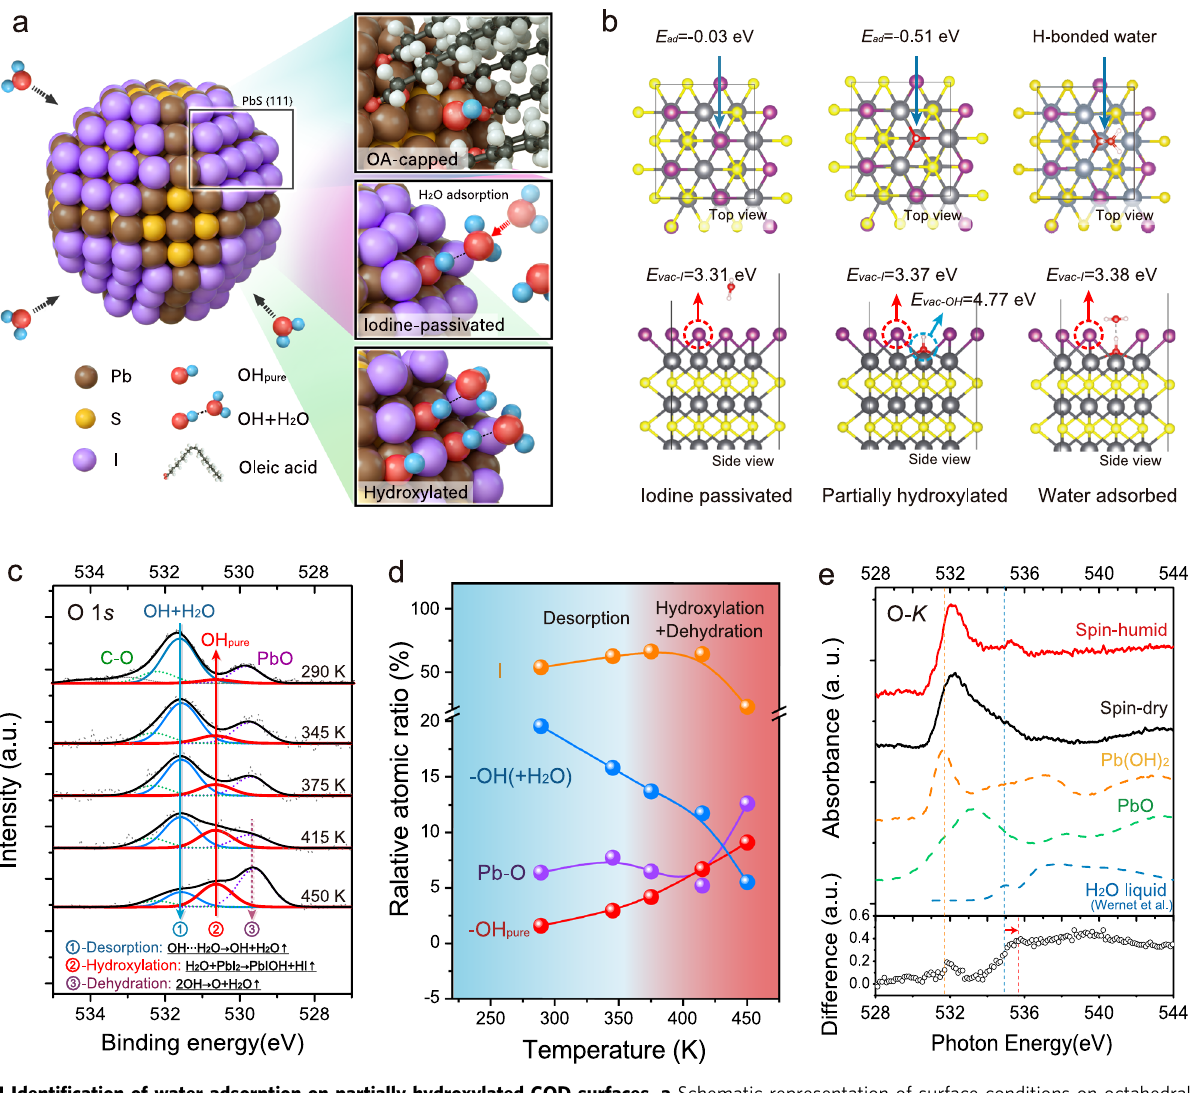
Fig. 1 Identi fi cation of water adsorption on partially hydroxylated CQD surfaces. a Schematic representation of surface conditions on octahedral PbS CQDs. The ideal model of PbS CQDs with atomic halide passivation is shown on the left. The proposed surface conditions on the Pb-terminated {111} facet are zoomed on the right. Top: the OA-capped facet with partial surface hydroxylation introduced in the synthetic process 15 ; Medium: Atomic iodine- passivated facet after ligand exchange; Below: the aggravation of surface hydroxylation followed by water adsorption under humid air. b The geometric structures of iodine-passivated (left), partially hydroxylated (middle) and water adsorbed PbS {111} facets (right) used in DFT calculation. The E ad and E vac stand for the adsorption energy of H 2 O and the vacancy formation energy, respectively. The purple spheres stand for iodine atoms, black ones for Pb atoms, yellow ones for S atoms, red ones for O atoms, and white ones for H atoms. c The temperature-dependent O1 s XPS spectra of PbS-I fi lm. d Atomic ratio of surface species relative to Pb 4 f core recorded at a temperature from 290 K to 450 K. e XAS spectra of PbS CQD fi lms at the oxygen K-edge with a high RH (50 – 60%) or low RH (<10%), respectively. The XAS spectra of liquid water and different surface chemical species observed in XPS O1 s